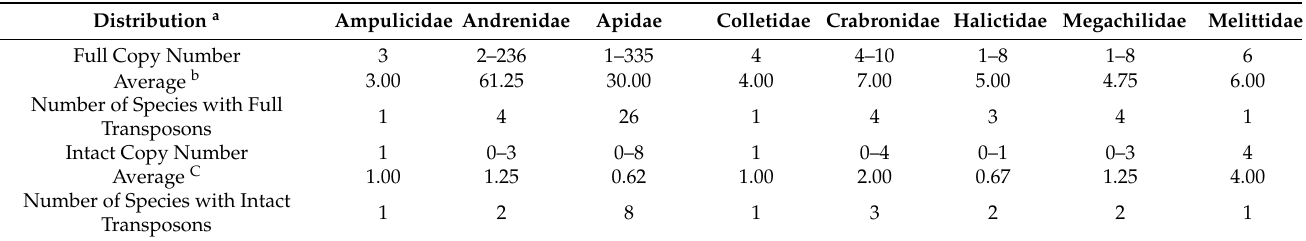
Table 1. Full and intact copy numbers of piggyBac ( PB ) transposons in genomes of